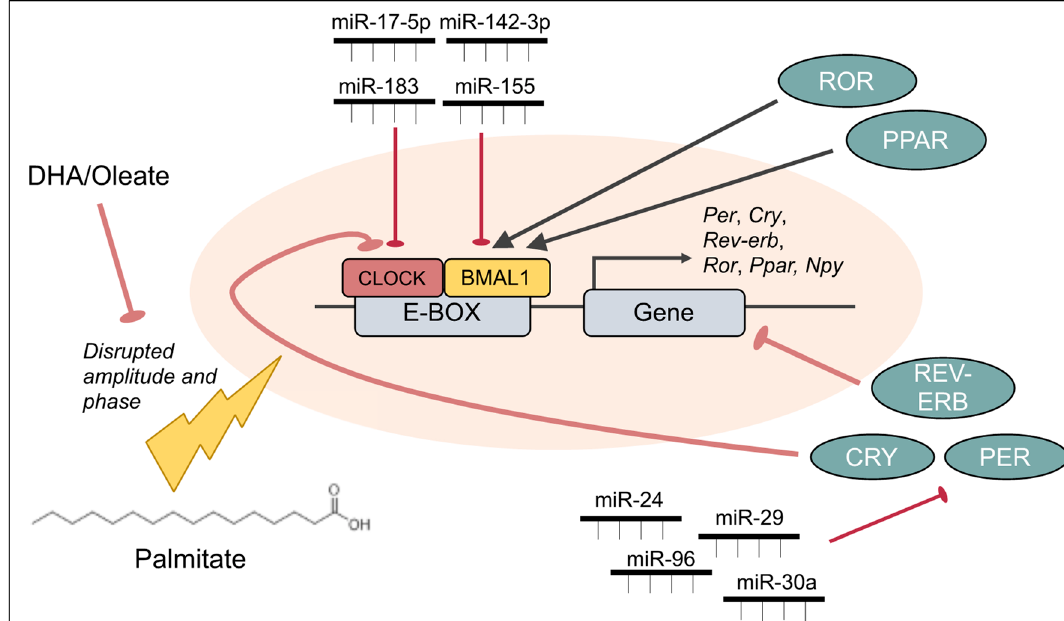
Figure 4. Circadian rhythm. The rhythmic expression of genes within a cell is controlled by a transcriptional-translational feedback loop primarily involving BMAL1, CLOCK, PER, and CRY proteins. The BMAL1 and CLOCK dimer binds to E-box sites in promoters to induce the expression of the downstream genes, which include Per and Cry . These negatively feedback onto the BMAL1:CLOCK dimer, thereby inhibiting their own transcription. Other circadian proteins involved in regulating the core elements of the loop include ROR, PPAR, and REV-ERB. Palmitate disrupts the rhythmicity of the loop, altering the amplitude or phase of rhythmic genes, including Bmal1 , Per2 and Npy . Core clock genes are also regulated by miRNAs. For example, Bmal1 is targeted by miR-155 and miR-142-3p, Clock is targeted by miR-17-5p and miR-183, and Pers are targeted by miR-24, miR-29, miR-30a, and miR-96.